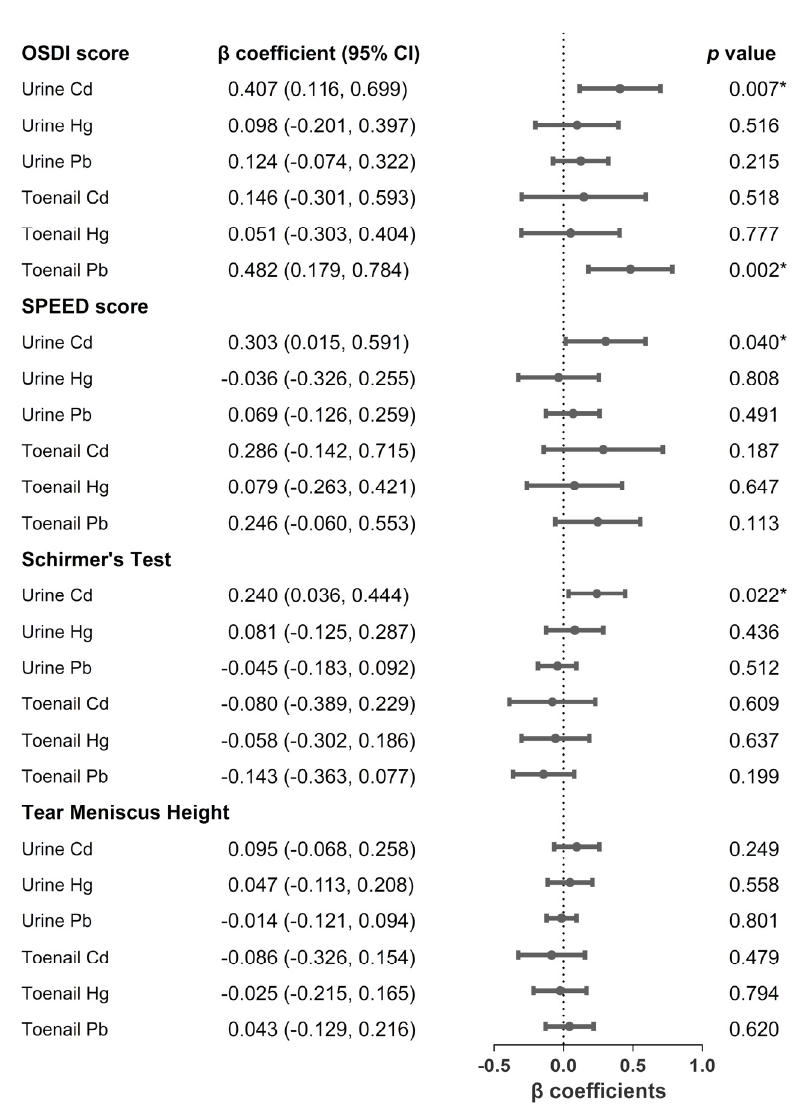
Figure 1. Association between urinary and toenail metals concentrations and dry eye metrics a . * p < 0.05. a Data were adjusted for smoking and drinking habits, age, temperature, humidity, and fasting plasma glucose. Abbreviations: OSDI, ocular surface disease index; SPEED, standardized patient evaluation of eye dryness questionnaire; Cd, cadmium; Hg, mercury; Pb, lead.